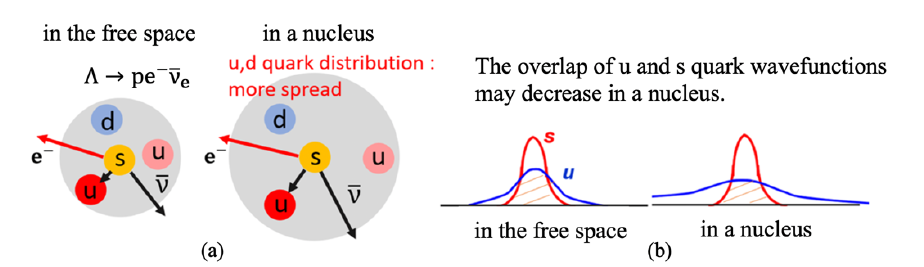
Fig. 1(a). Conceptual illustration for beta-decay of Λ in the free space (left) and in a nucleus (right). Fig. 1(b). Illustration for wavefunctions of the initial state s quark and the final state u quark in the free space (left) and in a nucleus